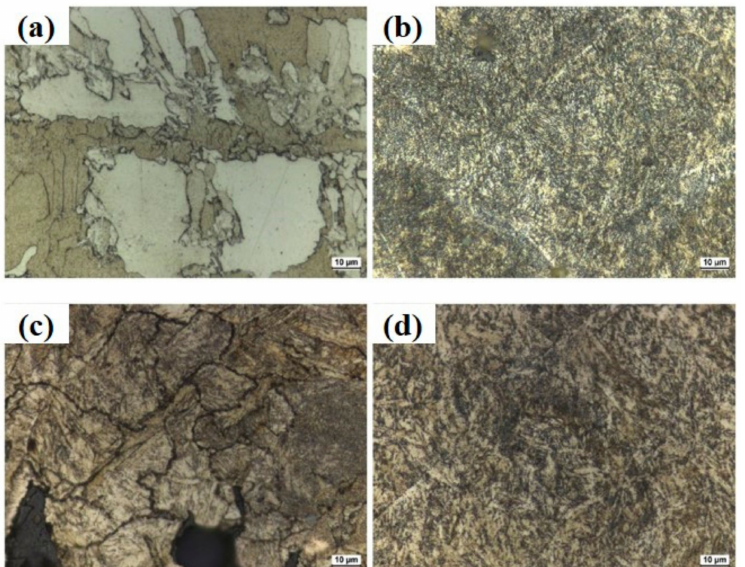
Figure 6. Optical micrographs of as built 17–4 PH SS perpendicular to the build direction: ( a ) gas-atomized at 64 J / mm 3 , ( b ) gas-atomized at 104 J / mm 3 , ( c ) water-atomized at 64 J / mm 3 , and ( d ) water-atomized at 104 J / mm 3